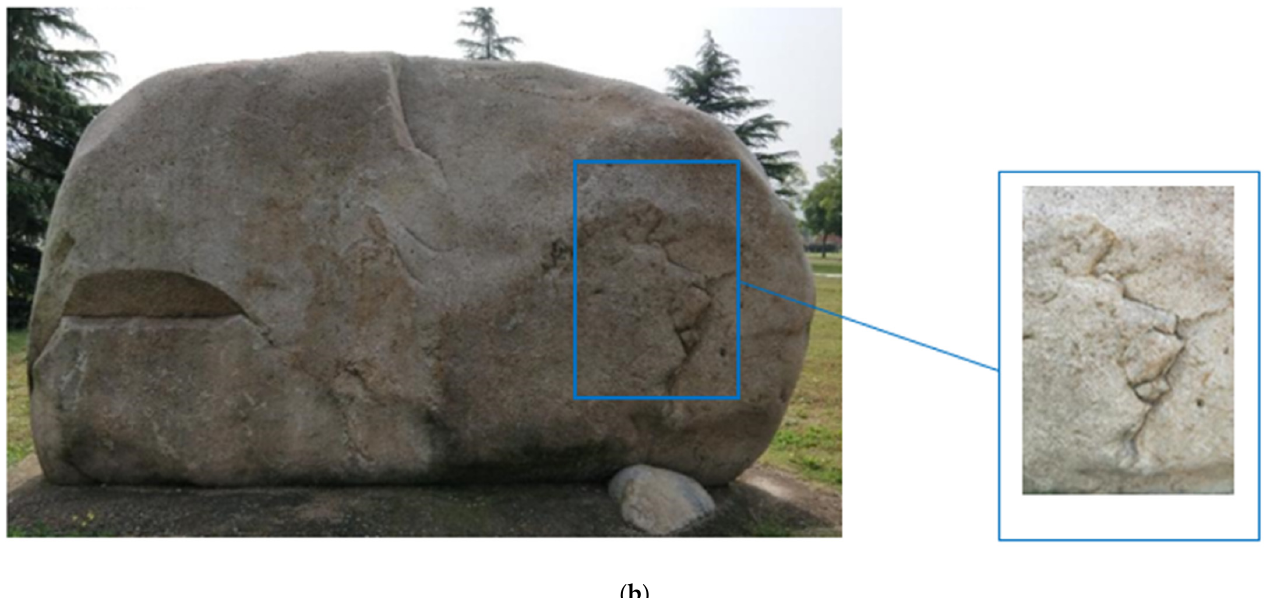
Figure 4. The real image of landscape stone.: ( a ) The real image of S-LS; ( b ) The real image of NS-LS.